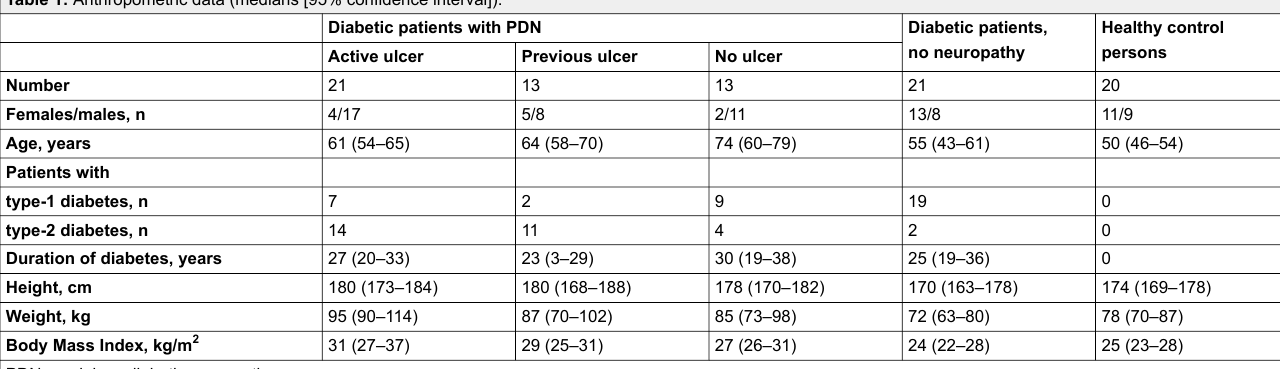
Table 1: Anthropometric data (medians [95% confidence